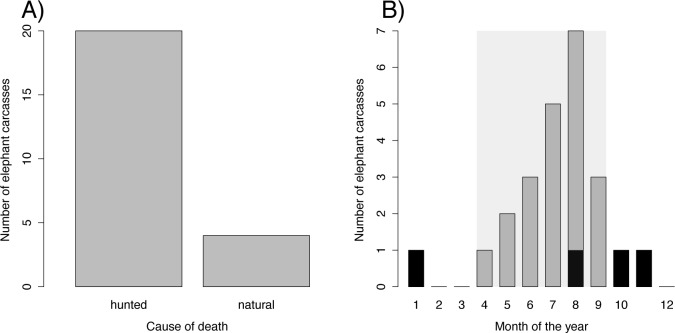
Availability of elephant carcasses between 2008 and 2010.In B) the grey bars represent trophy hunted elephants, black bars represent naturally dead elephants and the pale-grey polygon shows the hunting season.